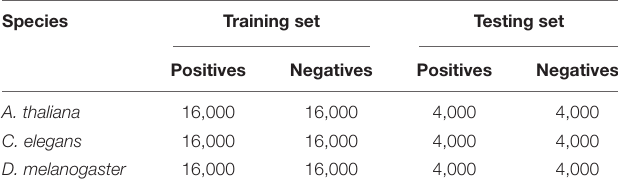
TABLE 1 | Summary of benchmark datasets in three